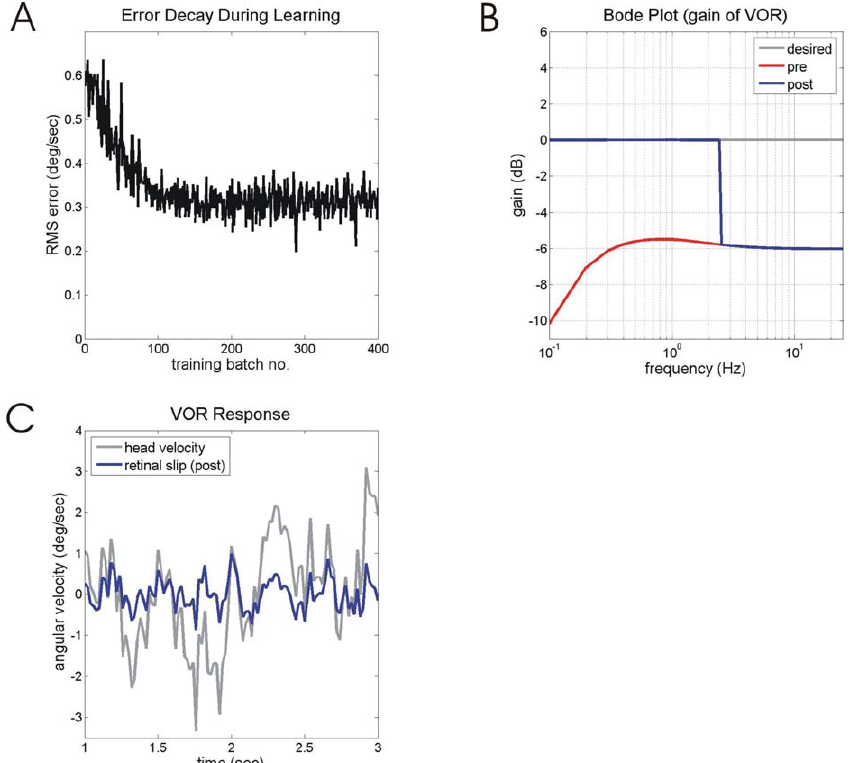
Figure 5. Model Performance with Delayed Retinal Slip and Frequencies . 2.5 Hz Removed from Cerebellar Inputs (A) Learning is now stable, unlike that shown in Figure 4A, but with a greater asymptotic retinal-slip error than that shown in Figure 3C. (B) System gain for sinusoidal input signals as a function of frequency. No learning occurs for frequencies above 2.5 Hz. (C) Example of retinal-slip to mixed-frequency head-velocity input before and after training. Retinal slip is still present at frequencies above 2.5 Hz.